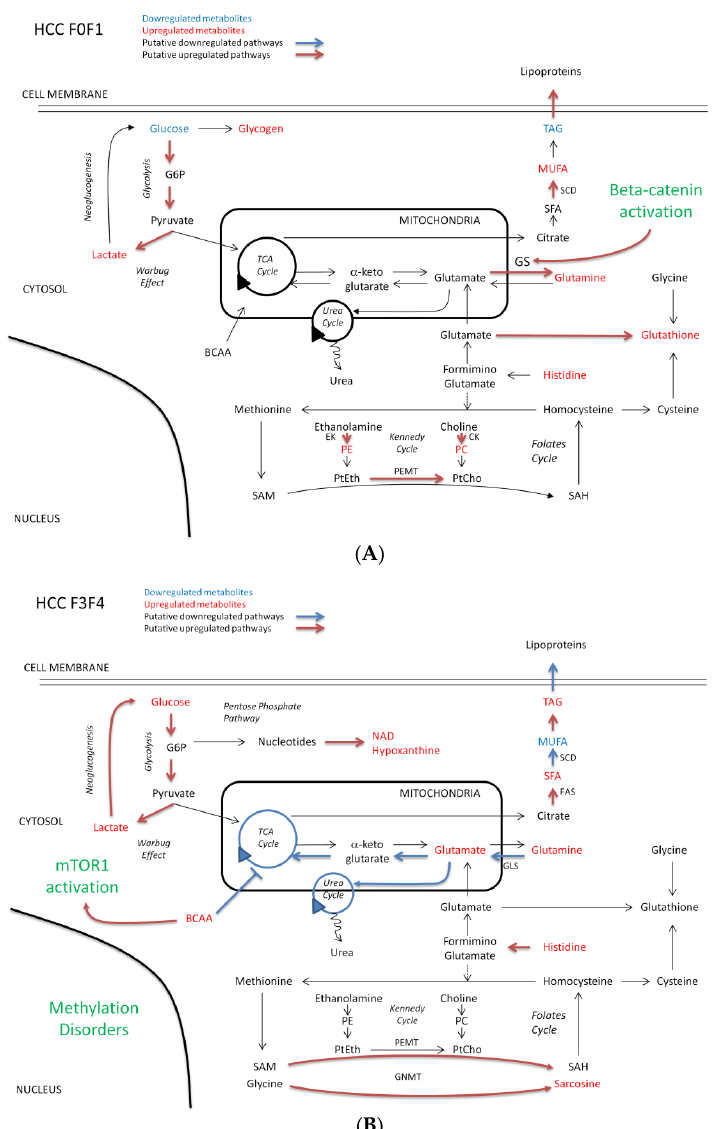
Figure 4. Discriminant metabolites identified and putative pathways involved in HCC according to the severity of fibrosis HCC-F0F1 ( A ) and HCC-F3F4 ( B ). Upregulated and downregulated metabolites are in red and blue, respectively. Upregulated and downregulated putative metabolic pathways are in red and blue, respectively. Abbreviations (in alphabetical order): BCAA, branched aminoacids; CK, choline kinase; EK, ethanolamine kinase, FAS, fatty acid synthetase; G6P, glucose-6-phosphate; GLS, glutaminase; GNMT, glycine N-methyltransferase; GS, glutamine synthetase; MUFA, monounsaturated fatty acids; NAD, nicotinamide adenine dinucleotide; PC, phosphocholine; PE, phosphoethanolamine; PEMT, phosphatidylethanolamine N-methyltransferase; PtCho, phosphatidylcholine; PtEth, phosphatidylethanolamine; SAH, S-adenosylhomocysteine; SAM, S-adenosylmethionine; SCD, stearoylcoA desaturase; SFA, saturated fatty acid; TAG, triacylglycerol; TCA, tricarboxylic